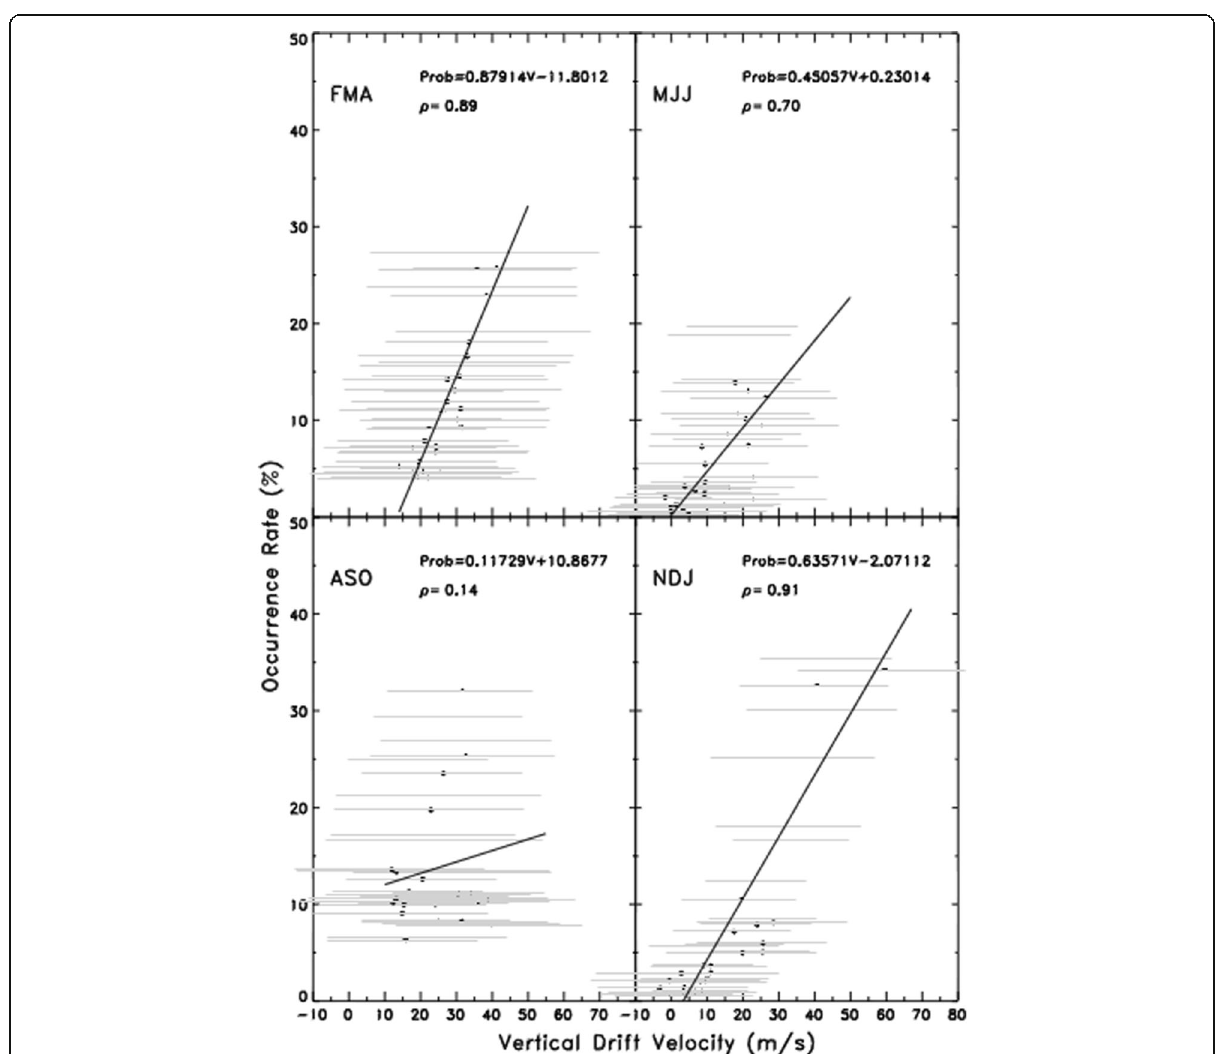
Fig. 4 Linear regression analysis of the topside vertical ion drift velocities between 1800 and 1900 LT with the ESF irregularity occurrence rates measured by the ROCSAT-1 satellite. (After Su et al.